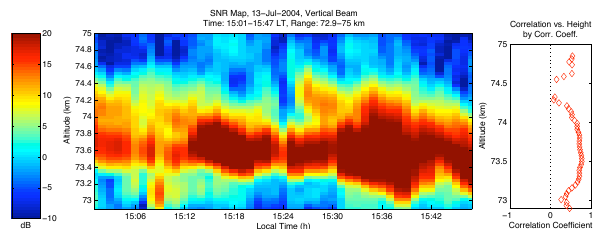
Fig. 9. Thin structures at 71.5, 72. 8, 73.5, and 74.8 km on May 29